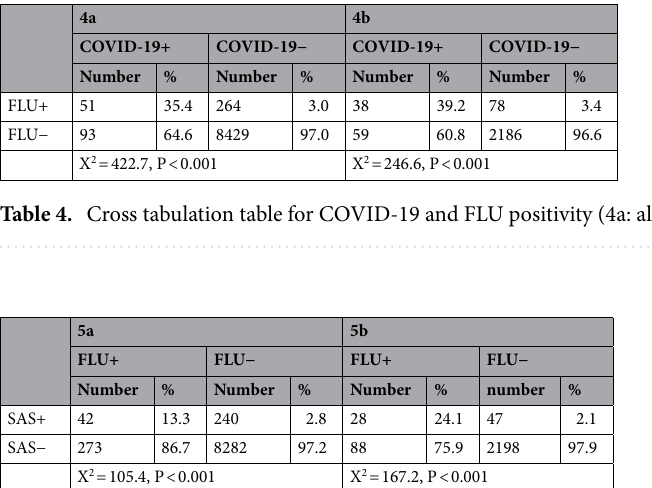
95% confidence interval p valueLower Upper 4.46E−08